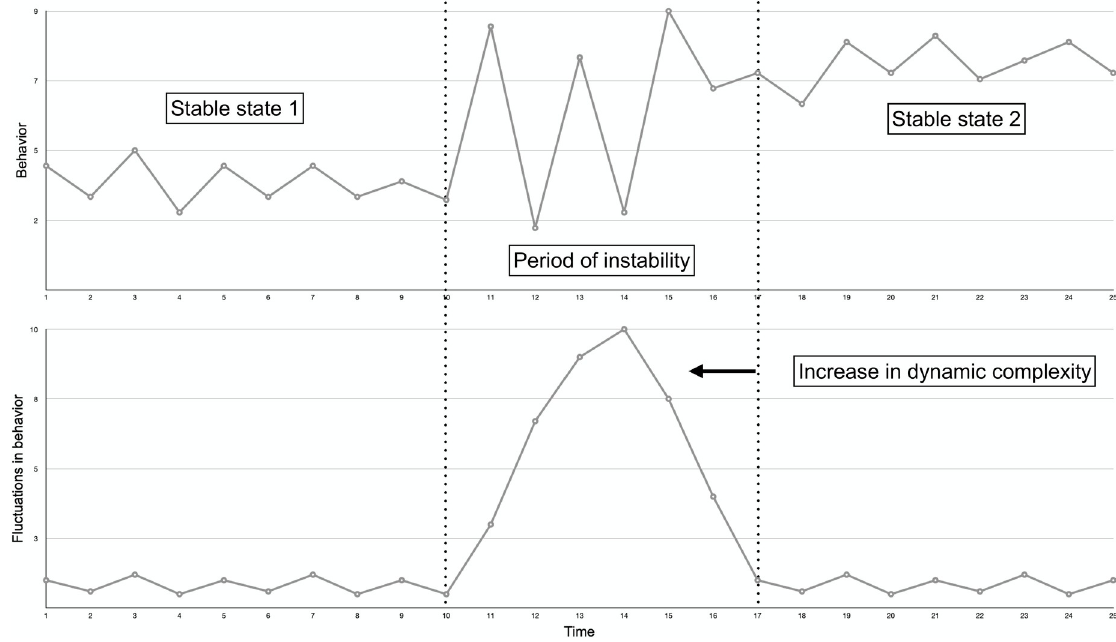
Fig 1. Conceptual illustration of critical fluctuations in a given behavior followed by a sudden gain (upper panel), expressed as the level of dynamic complexity (lower panel). The transition from a stable state (starting at day 1 and ending around day 10) to a second stable state (starting around day 17) is characterized by a period of instability in which the behavior of the system displays critical fluctuations (upper panel). The greater the fluctuations in the behavior, the higher the dynamic complexity score (lower panel). Work in critical transitions across various systems indicate that instability can be observed shortly before a phase transition; increases in dynamic complexity can thus be seen as a form of early warning signal for either sudden gains and/or losses in a given system [35, 37]. Note that the Figure’s x axis represents continuous time but does not refer to a specific time unit, as this approach can be used to describe both rapid- and slow-evolving processes. The time unit here can thus conceptually vary from seconds to years.